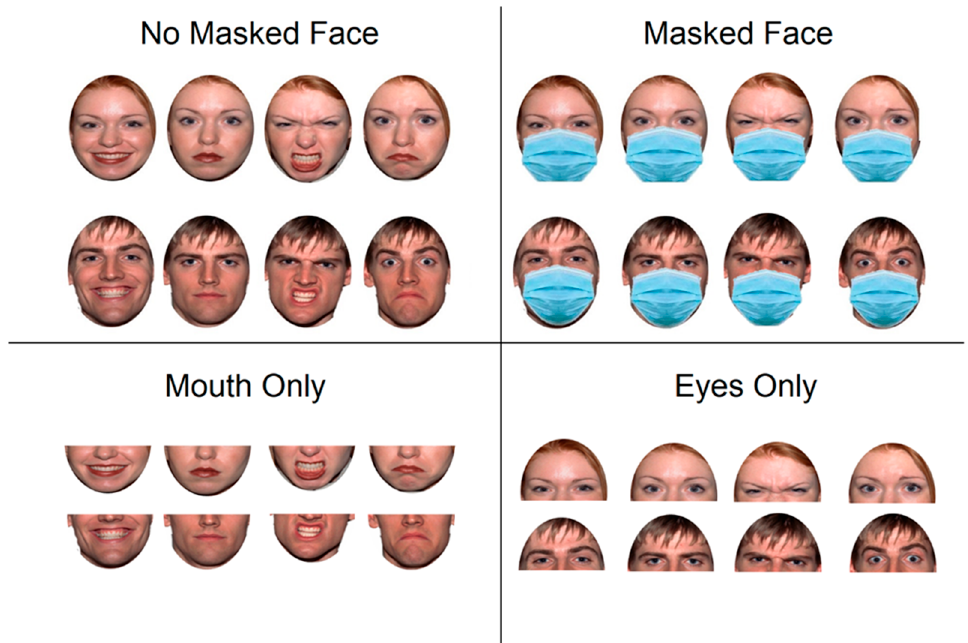
Figure 1. Experimental manipulation of the stimuli in each condition.